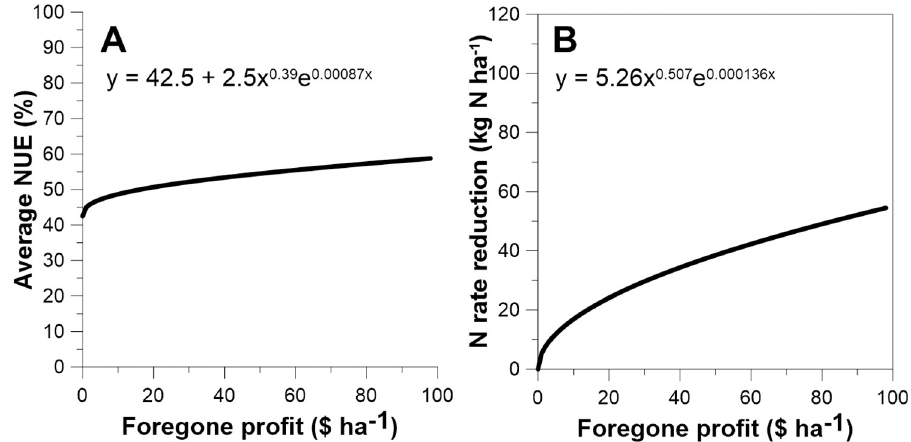
Fig 6. With modest sub-EONR fertilization, average NUE improvements of ~10% can be realized. (A) Averaged over the three studies, this equation shows the average NUE shown relative to foregone profit when N fertilization is less than EONR. (B) Model showing the average N saved with sub-EONR fertilization relative to foregone profit.